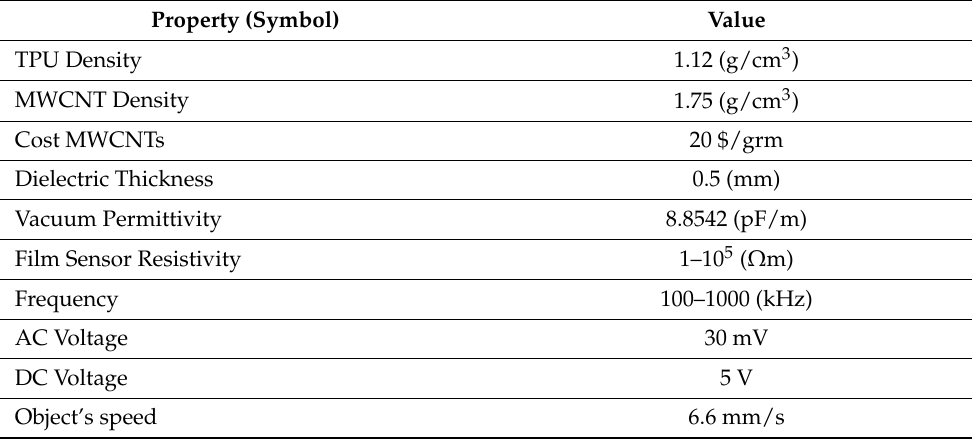
Table 1. Experiment testing parameters and